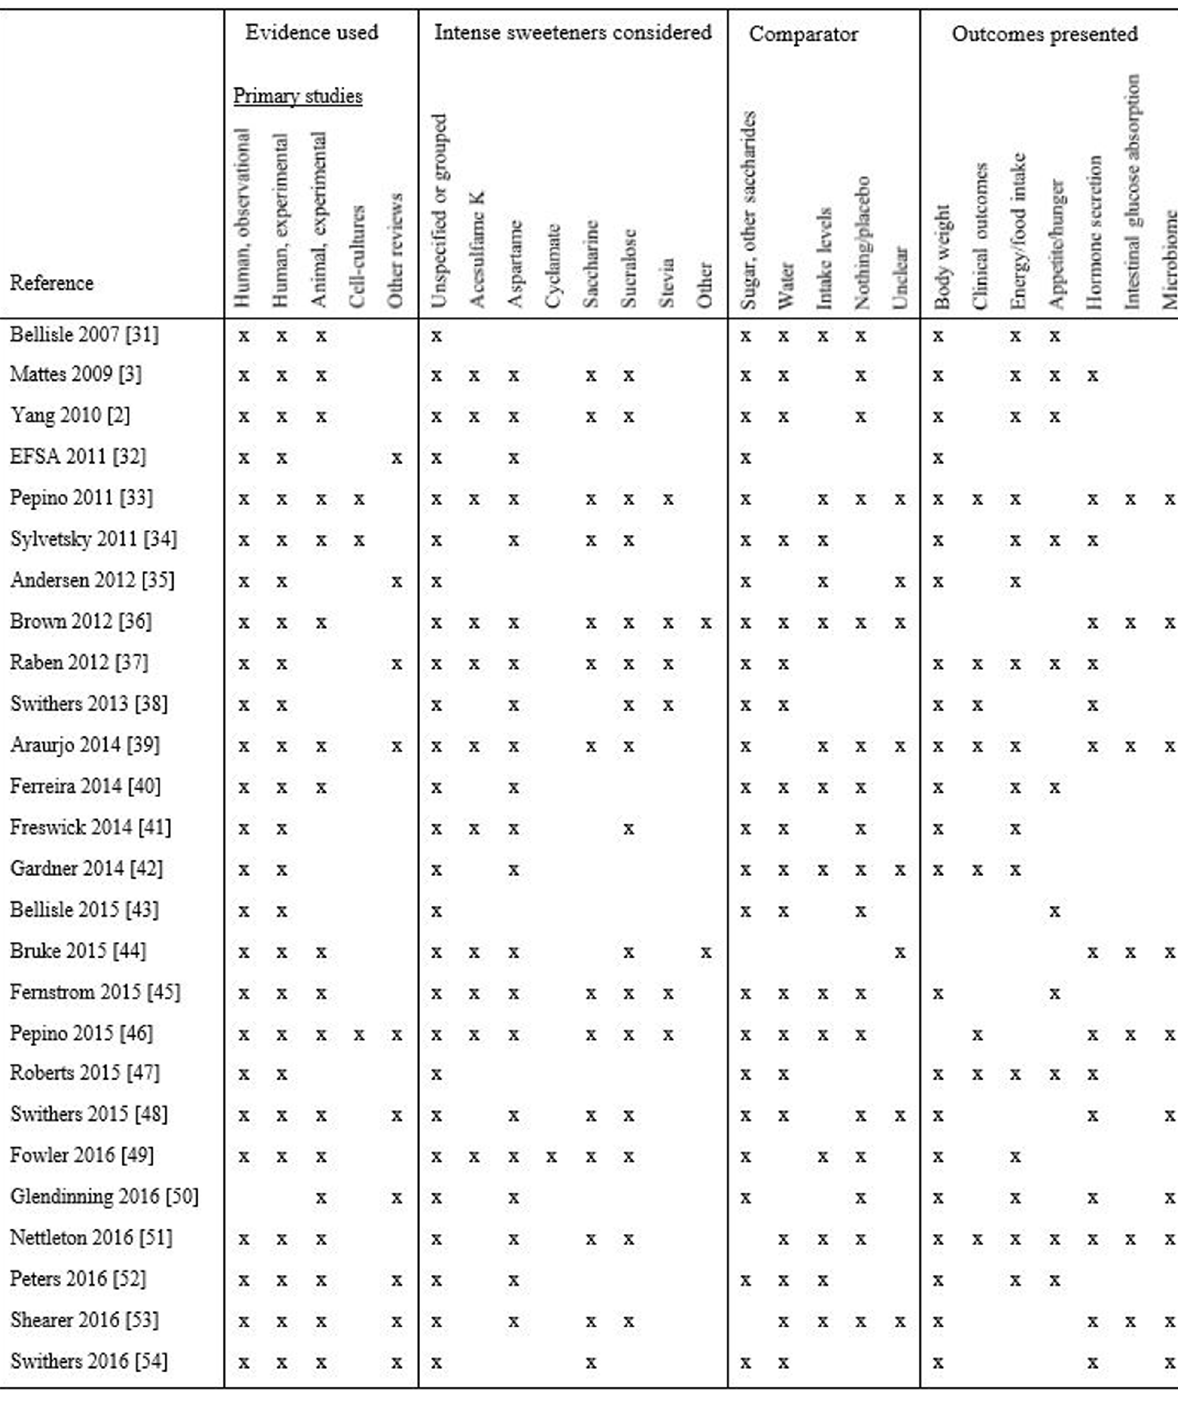
PLOS ONE | https://doi.org/10.1371/journal.pone.0199558 July 18,